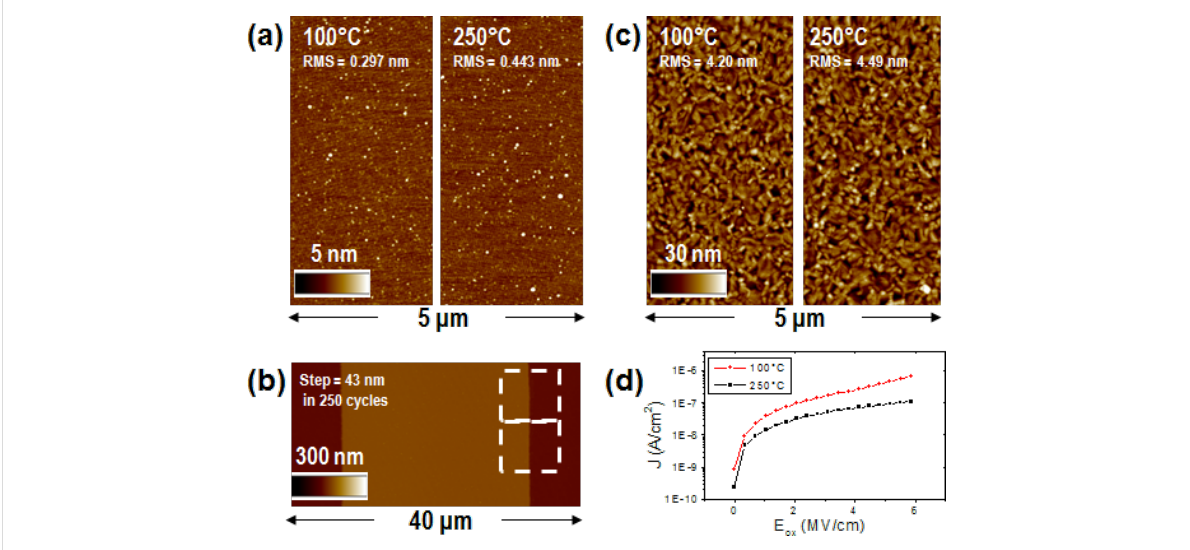
Figure 1: a) Comparison between tapping mode atomic force microscopy (tAFM) morphologies of low temperature (left) and standard temperature (right) dielectric materials deposited on a Si wafer; b) AFM local step height of the lift-off patterned low temperature dielectric; c) comparison between tAFM morphologies of low temperature (left) and standard temperature (right) dielectric material deposited on an Al coated Si wafer; and d) current density leakage through low temperature and standard temperature dielectric